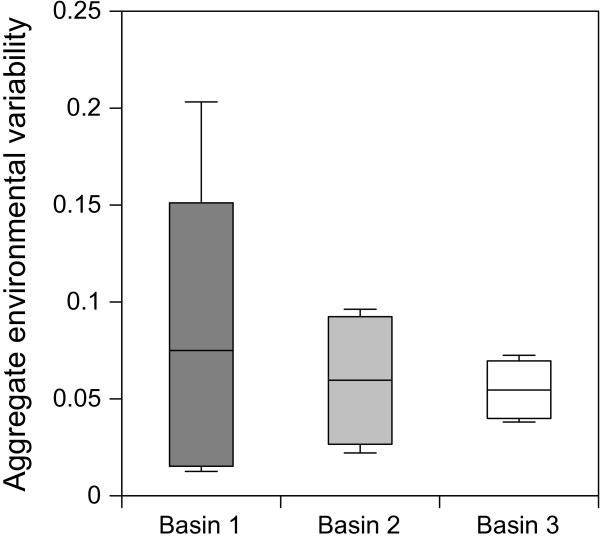
Degree of environmental variability expressed as aggregate coefficients of variation of the sampled physical-chemical parameters in different sampling sites. Boxplots show the cumulative coefficient of variation (SD/mean) of salinity, pH, dissolved oxygen concentration, and temperature during the entire study period (1997-2010). Dark grey box is for basin 1, light grey box for basin 2, and white box for basin 3.